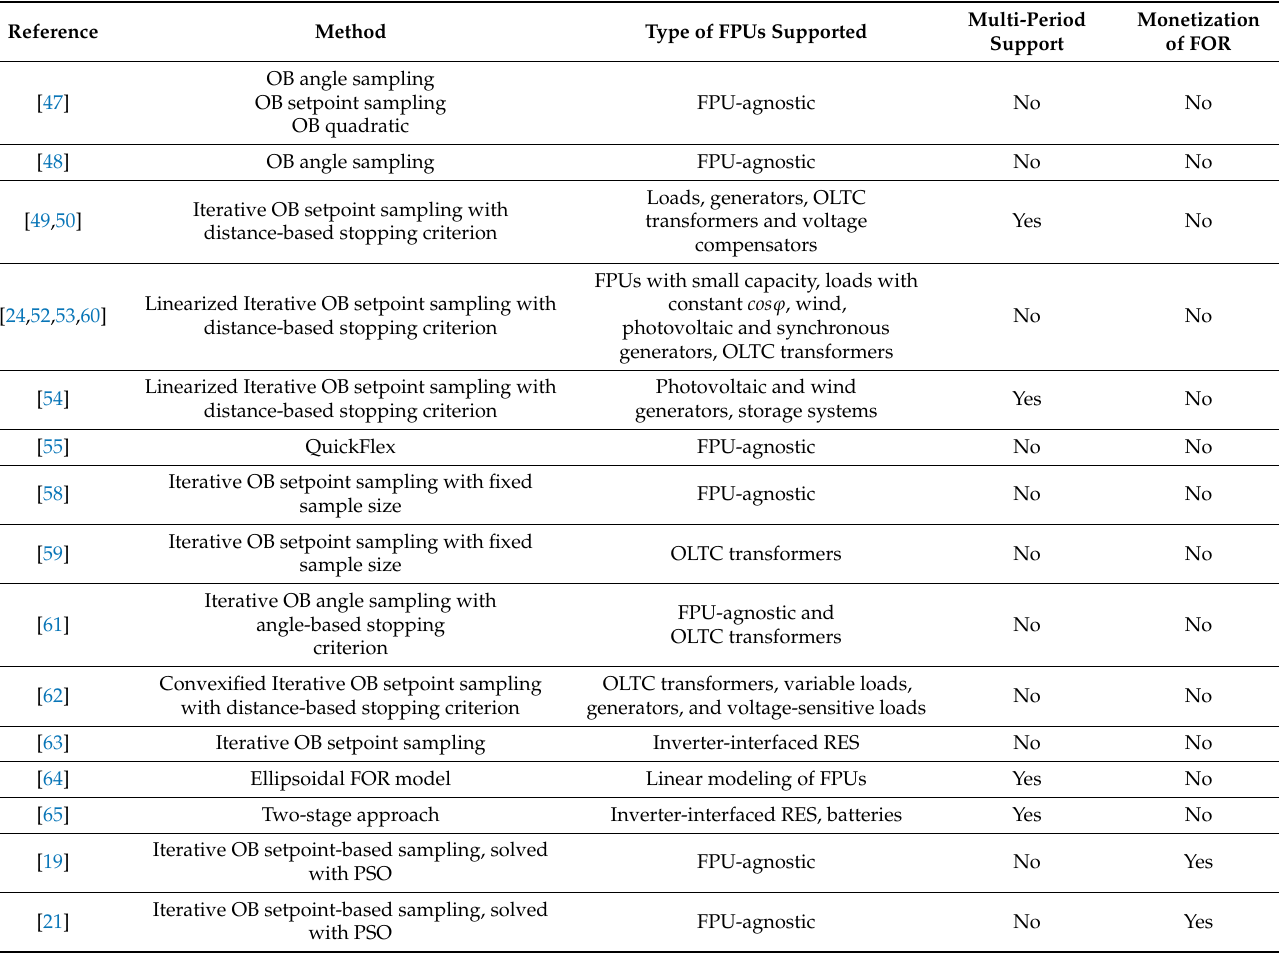
Table 4. A summary of the reviewed OB